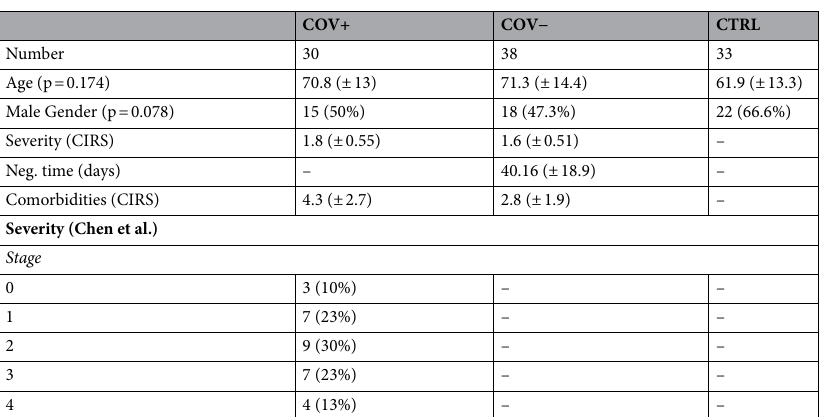
Table 1. Clinical characteristics of the subjects involved in the study. Data are presented as average with the standard deviation (± SD) or percentage (n %) and with the two sided p-values (p). Differences between the groups were analysed using Mann–Whitney test or One-Way ANOVA test for continuous variables and Chi-square test or Fisher Exact test for categorical variables. Severities and comorbidities were considered as described by Chen et al. 46 and following the CIRS classification. Neg. Time represents the time between the first positive nasopharyngeal SARS-CoV 2 test and the last negative